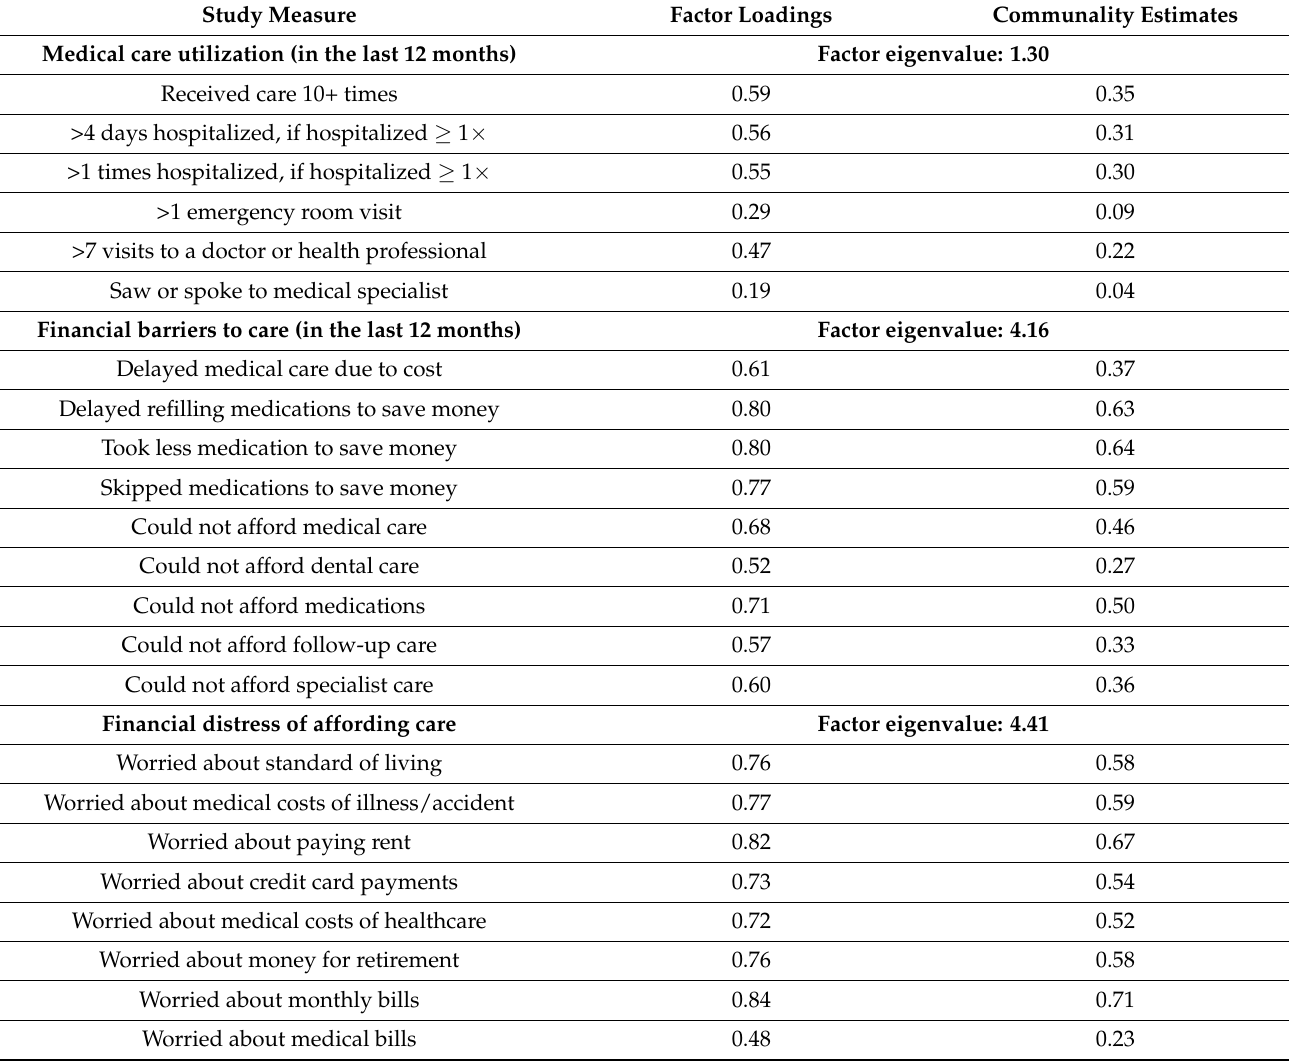
Table 2. Extracted factor characteristics of each study domain following factor